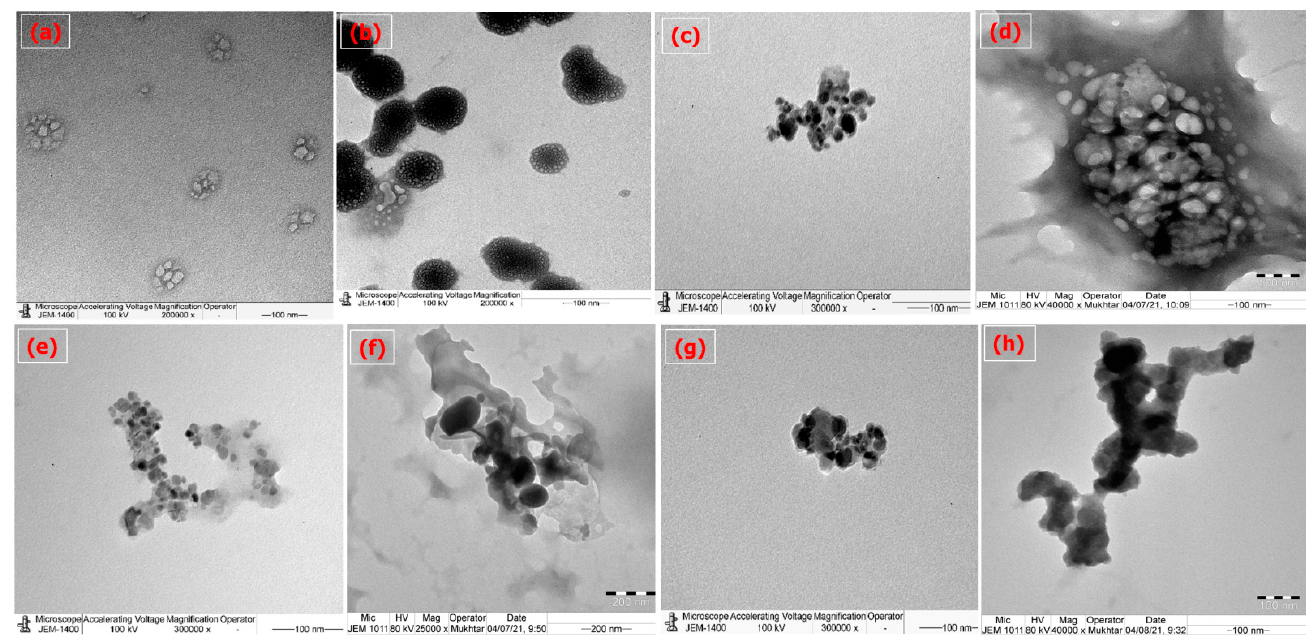
Figure 4. TEM analysis of ( a ) CS ‐ g ‐ SA ‐ modified AMPS; ( b ) CS ‐ g ‐ OA ‐ modified AMPS; ( c ) CS ‐ g ‐ LA ‐ modified AMPS; ( d ) CS ‐ g ‐ LLA ‐ modified AMPS; ( e ) CS ‐ g ‐ SA ‐ modified NIPAm; ( f ) CS ‐ g ‐ OA ‐ modified NIPAm; ( g ) CS ‐ g ‐ LA ‐ modified NIPAm; and ( h ) CS ‐ g ‐ LLA ‐ modified NIPAm.